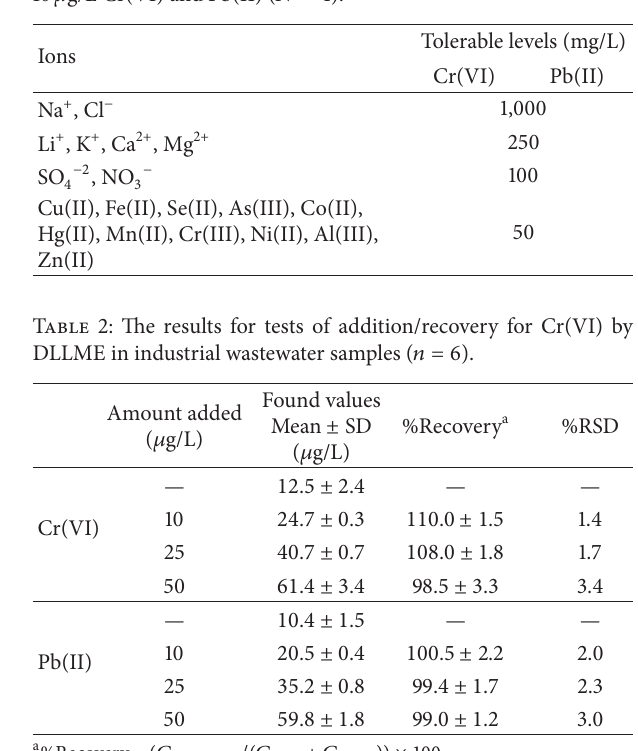
Table 1: Tolerable levels of concomitant ions for the extraction of 10 𝜇 g/L Cr(VI) and Pb(II) ( 𝑁 = 4 ).